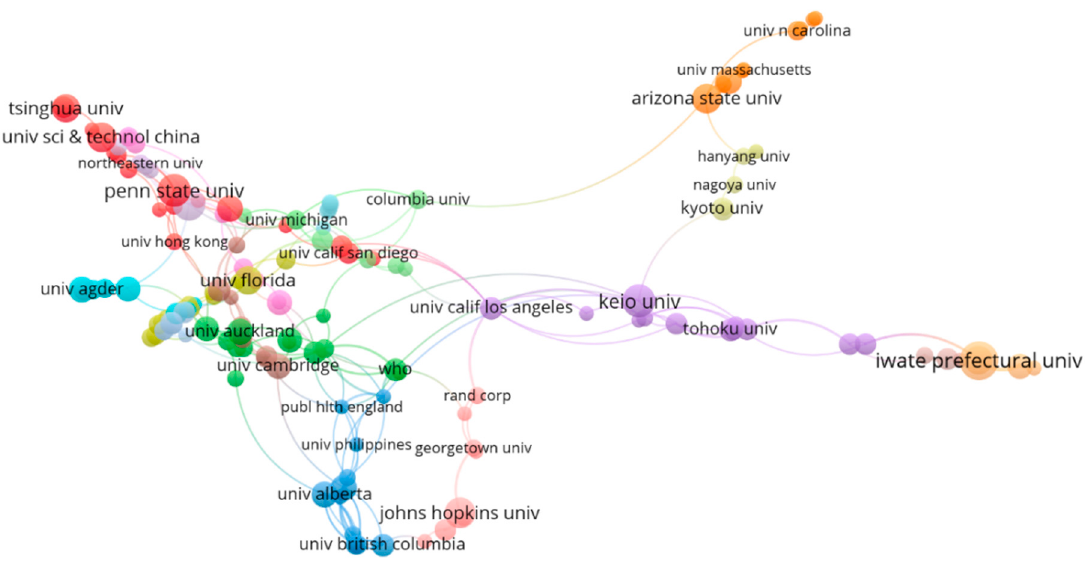
Figure A1. Collaboration network map of main countries.